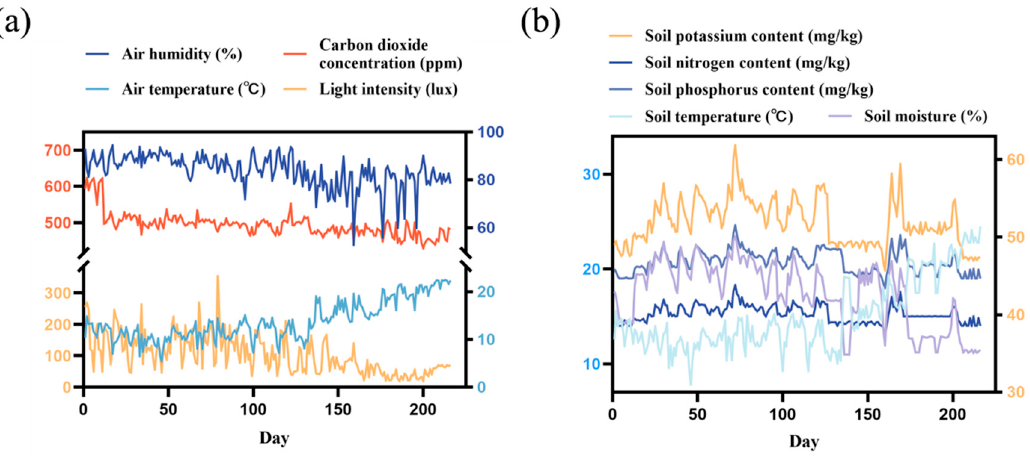
Figure 4. Changes of meteorological parameters and soil parameters in greenhouse during the whole seedling. ( a ) Meteorological sensors; ( b ) soil sensors.